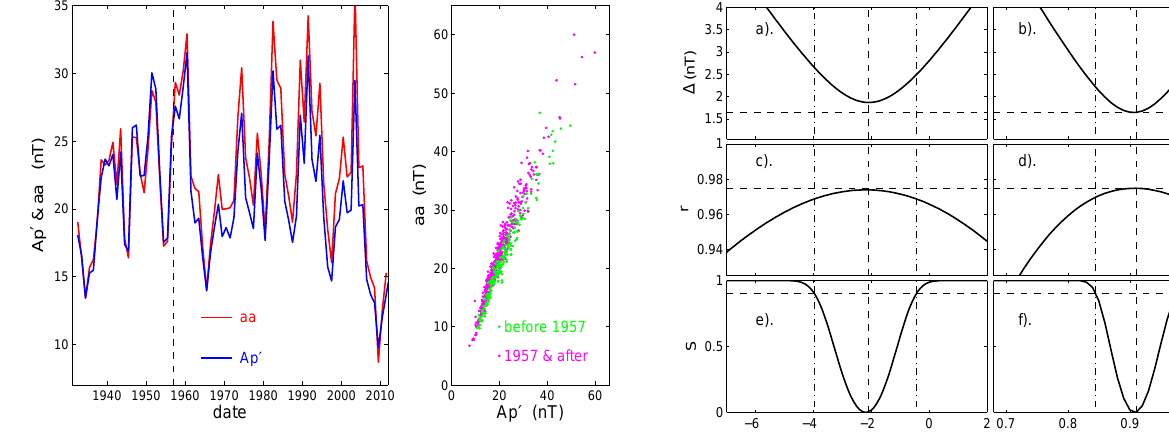
Fig. 2. The effect of recalibrating the standard aa index after 1 Jan- uary 1957 with (left panels) an offset factor δ and (right panels) an amplification factor g . ( a and b ). The root mean square deviation 1 of monthly mean Ap 0 ( Ap linearly regressed onto aa using the data before 1957) and monthly mean corrected aa for data after 1 Jan- uary 1957 as a function of (a) δ and (b) g . The horizontal dashed line gives the corresponding value for 1 January 1932–31 Decem- ber 1956. ( c and d ) The correlation r of monthly aa and Ap 0 for the full data sequence (1 January 1932–31 December 2012) as a func- tion of (c) δ and (d) g . The horizontal dashed line gives the value for 1 January 1932–31 December 1956. ( e and f ) The significance, S , of the difference between the best correlation and that at general δ (in the case of e ) or g (in the case of f ) from a Fisher Z test. The dashed line shows the 0.9 significance level. The vertical dashed lines in ( a , c and e ) are the optimum δ = − 2 . 2 ± 1 . 8, the uncertainty band (at the 90% uncertainty level) being shown by the vertical dot-dash lines. The corresponding lines for the optimum g and uncertainty band are shown in b , d and f at g = 0 . 910 ± 0 .